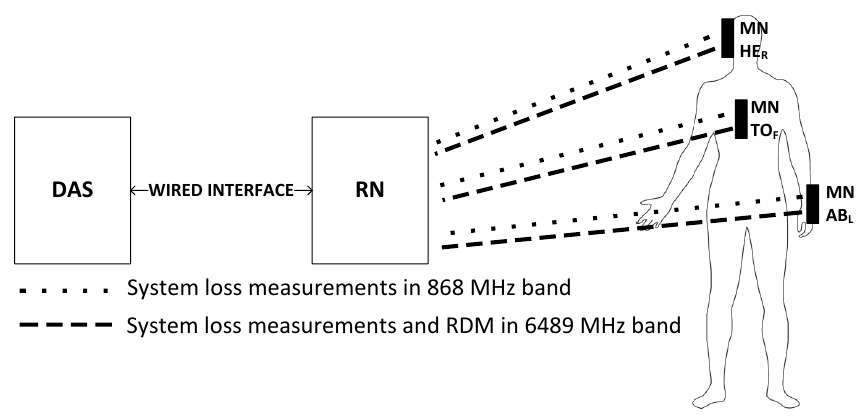
Figure 2. A schematic diagram of the measurement equipment.